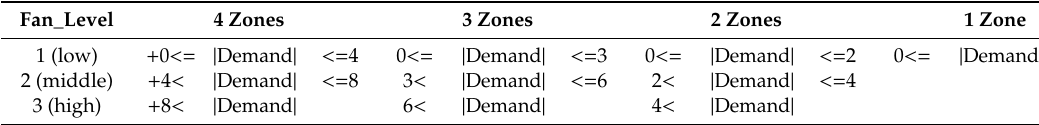
Table 2. Defined fan levels for the air flow demand control.